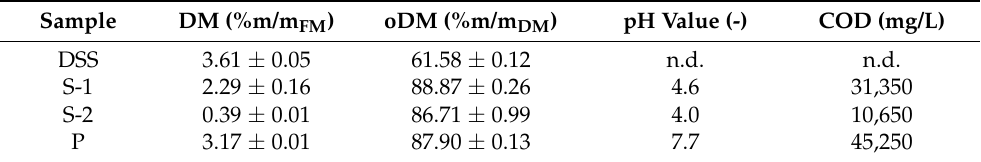
Table 2. Dry matter (DM) concentration based on fresh matter (FM), organic dry matter (oDM) concentration, pH value and chemical oxygen demand (COD) for digested sewage sludge (DSS) and the spruce based (S-1 and S-2) as well as the poplar based press waters (P). Mean values ± standard deviation (n = 4), (n.d. = not